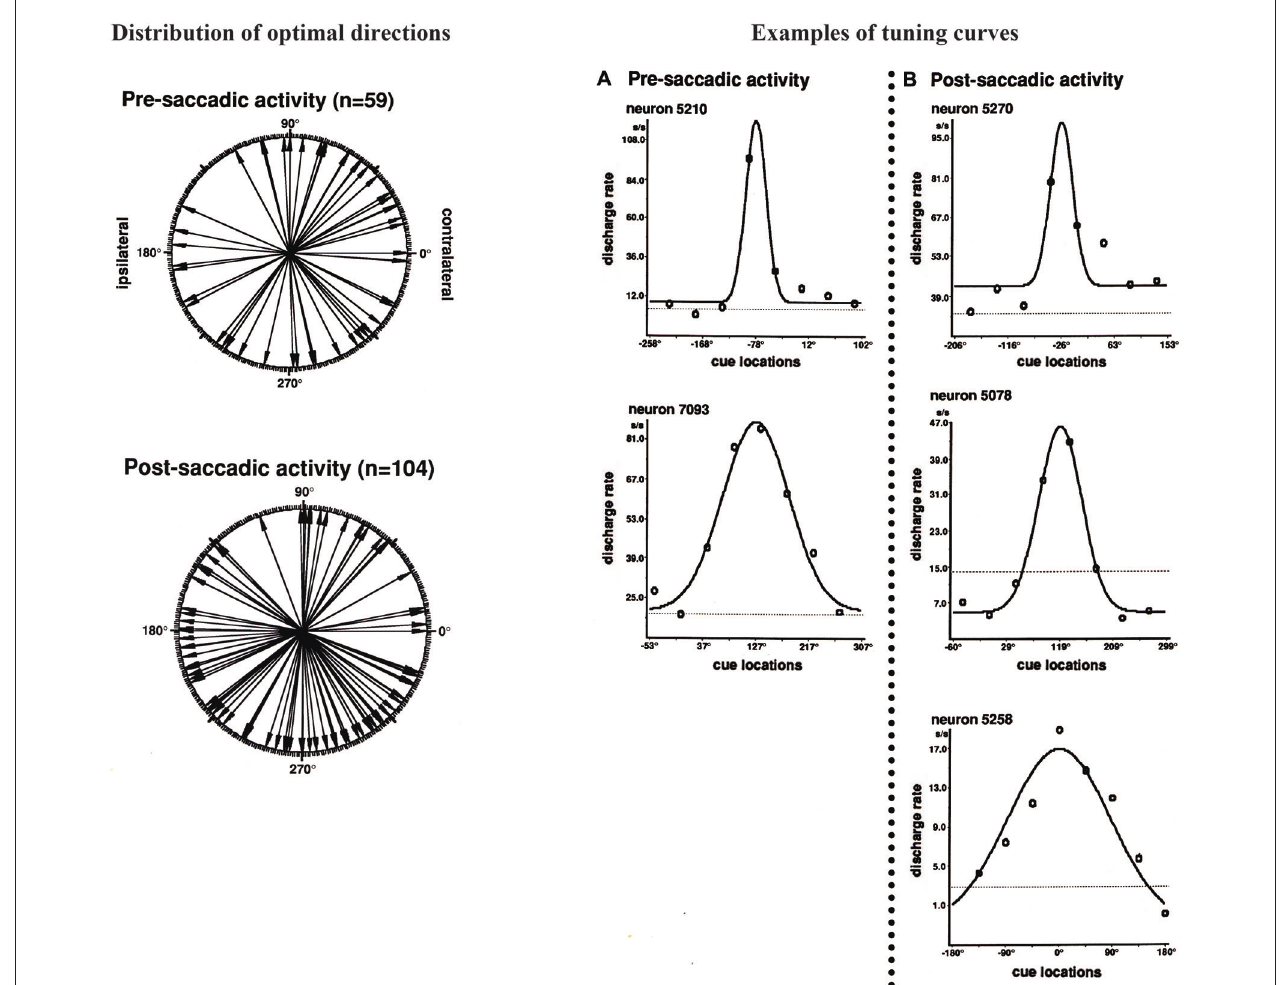
from the left hemisphere. Right : Examples of tuning curves of saccade-related activities for individual neurons. The tuning curves were constructed by fitting neural activities in Gaussian function. (A) Pre-saccadic activity. (B) Post-saccadic activity. Adapted from Funahashi et al.